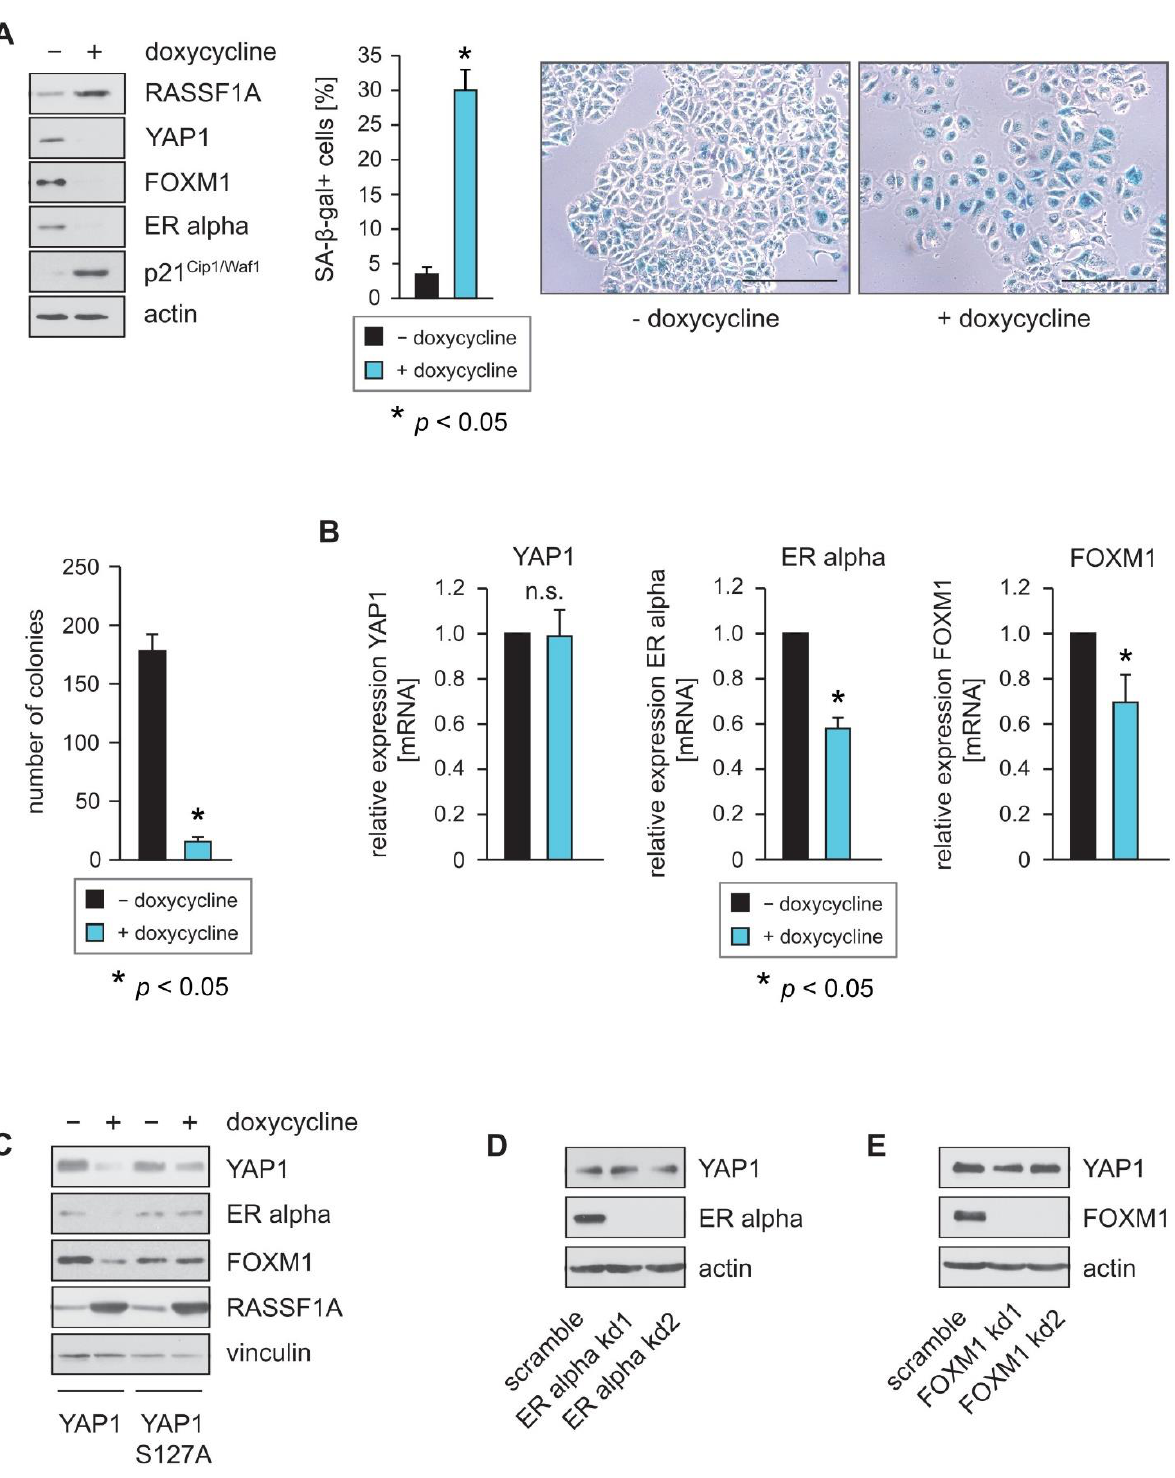
Figure 1. RASSF1A decreases YAP1 protein levels and inhibits FOXM1 and ER alpha expression. ( A ) Expression of RASSF1A in conditional RASSF1A MCF7 cells was induced by culturing cells in the presence of 1 µ g/mL doxycycline. Cell extracts from induced and non-induced conditional RASSF1A cells were prepared 48 h after doxycycline administration and were analyzed by Western blotting using the indicated antibodies (left panel). Conditional RASSF1A cells were plated at equal densities and grown for 5 days in the presence or absence of doxycycline as indicated. RASSF1A-induced senescence was subsequently monitored by SA- β -gal staining (right panel). Bars = 100 µm. Quantification of senescent cells was